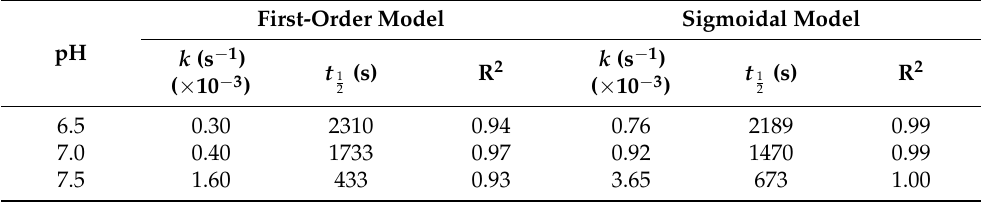
Figure 2. Adjustment of the sigmoidal model on the kinetic data obtained for Qt thermal degradation at various pH. Table 1. Kinetic data generated after implementing first-order and sigmoidal kinetic models.